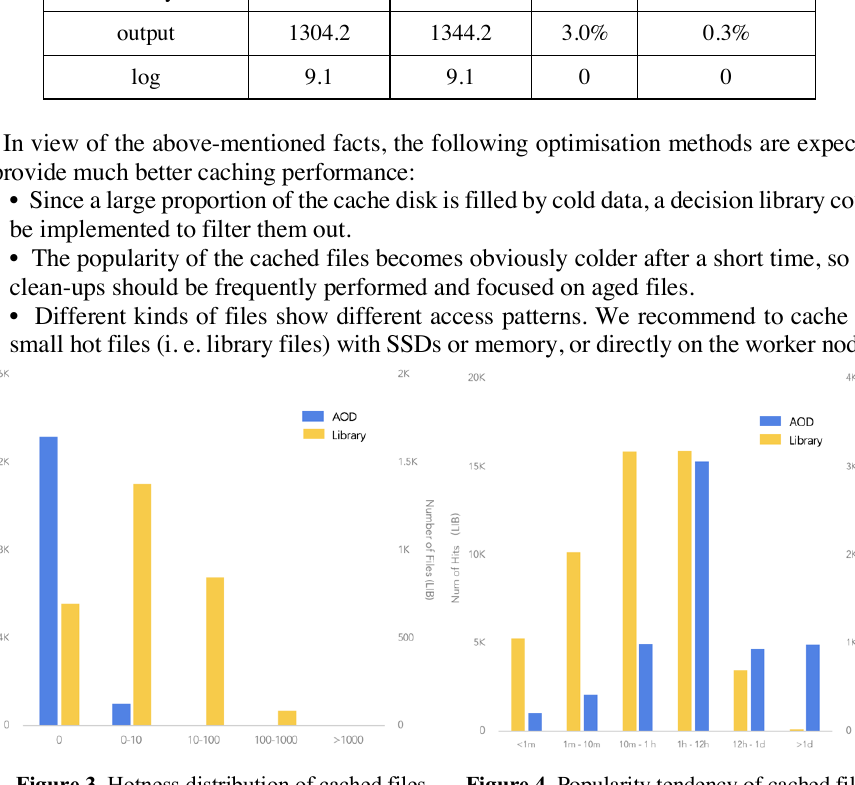
Figure 3. Hotness distribution of cached files Figure 4. Popularity tendency of cached